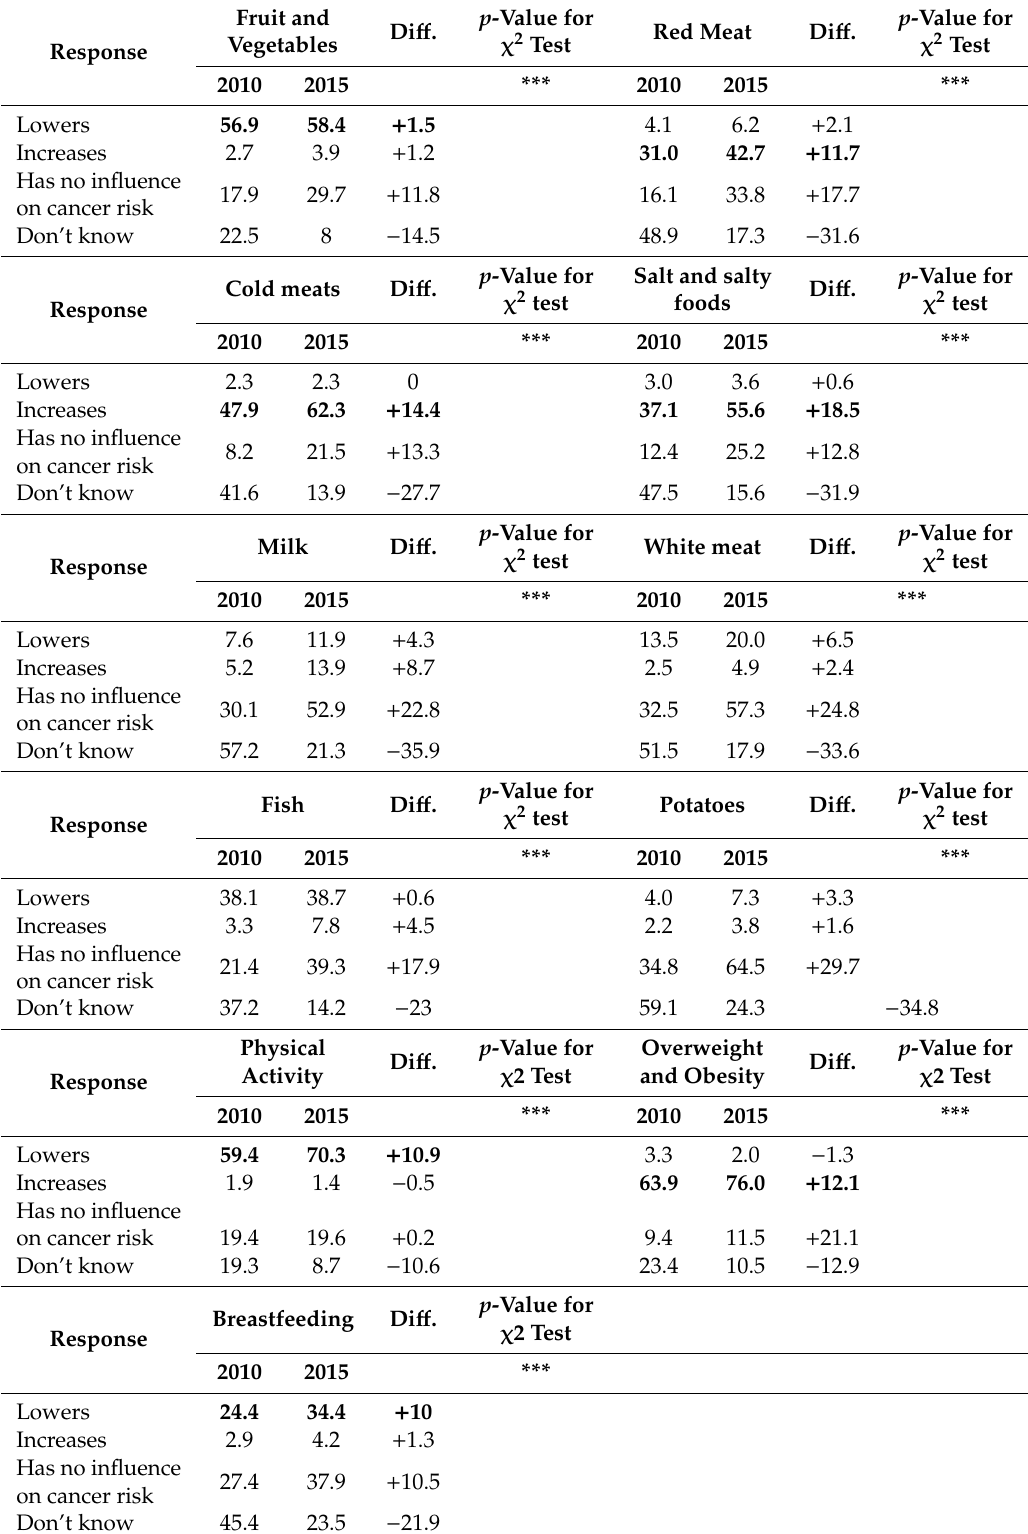
Table 7. Evolution of participant perceptions of nutritional factors: perception rates in 2010 and 2015.